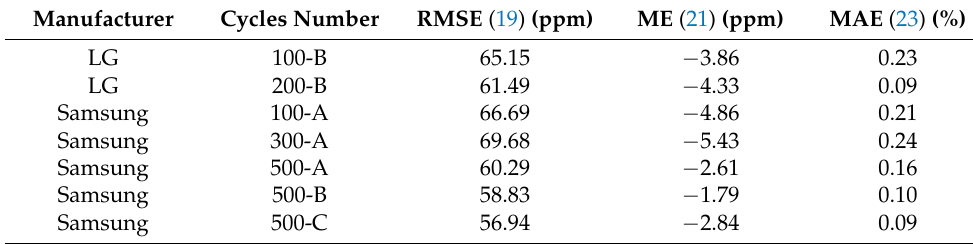
Table 8. Error comparison obtained with the aged cell. Voltage V B error estimation.